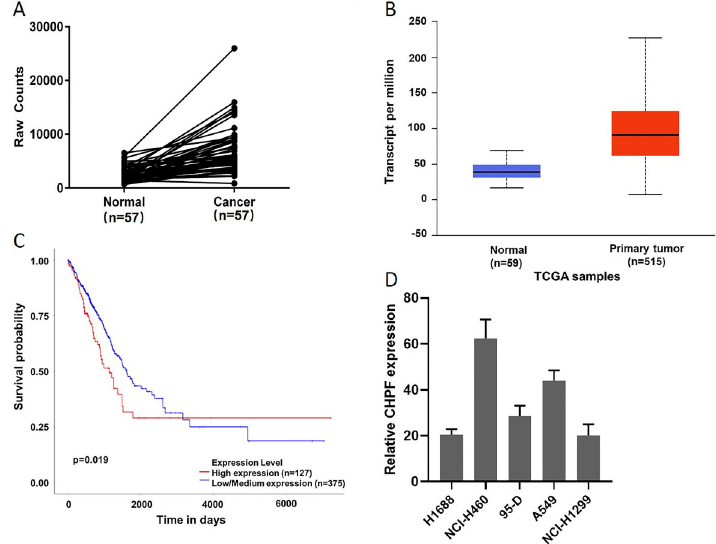
Figure 1. Chondroitin polymerizing factor ( CHPF ) expression in lung cancer patients and lung cancer cell lines. A , CHPF mRNA expression in the lung cancer and normal tissues of samples. The solid line that shows the trend in gene expression. B , CHPF expression in human lung cancer compared to normal tissue in the TCGA database. C , Elevated CHPF expression corresponded to shorter overall survival of lung adenocarcinoma (LUAD) patients from the TCGA database. D , CHPF mRNA expression of fi ve lung cancer cell lines was detected by qRT- PCR and calculated by the 10000/2 W Ct equation. Data are reported as median and interquartile range ( B ) and means ± SD ( D